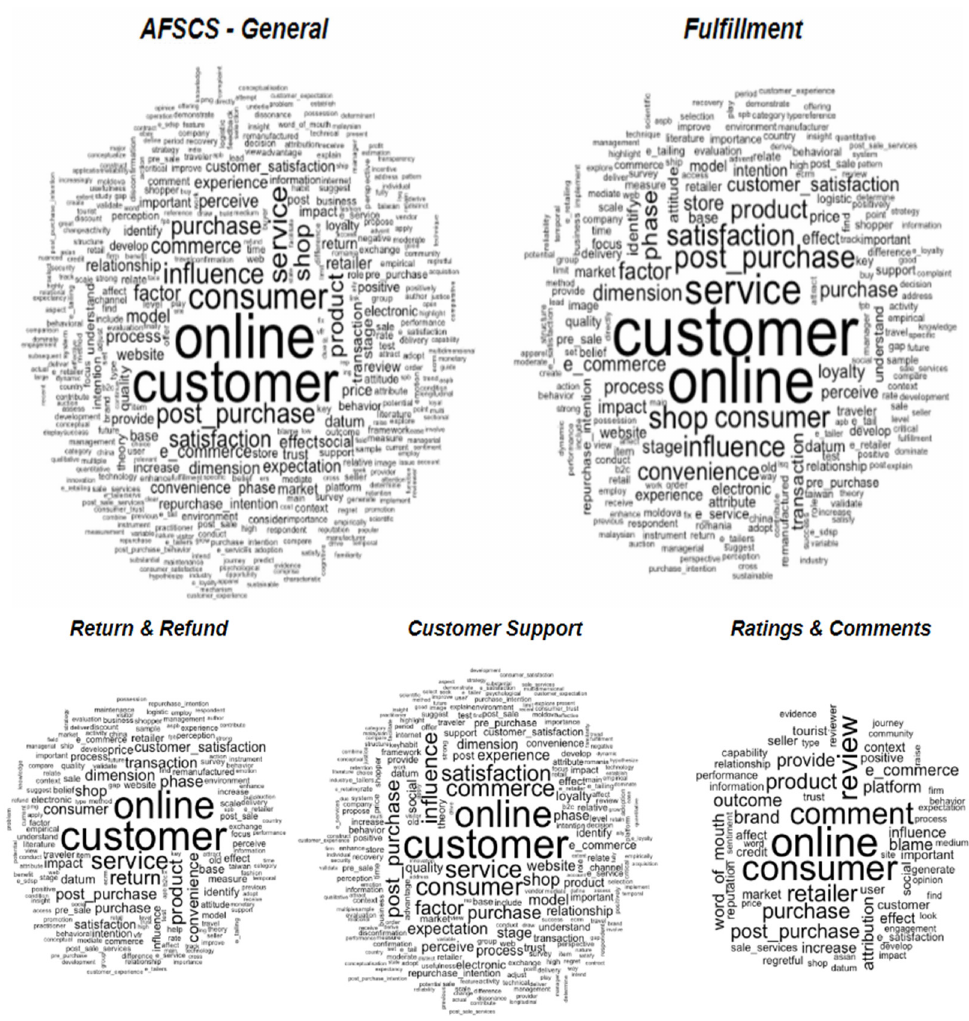
Figure 4. World cloud for each thematic cluster.